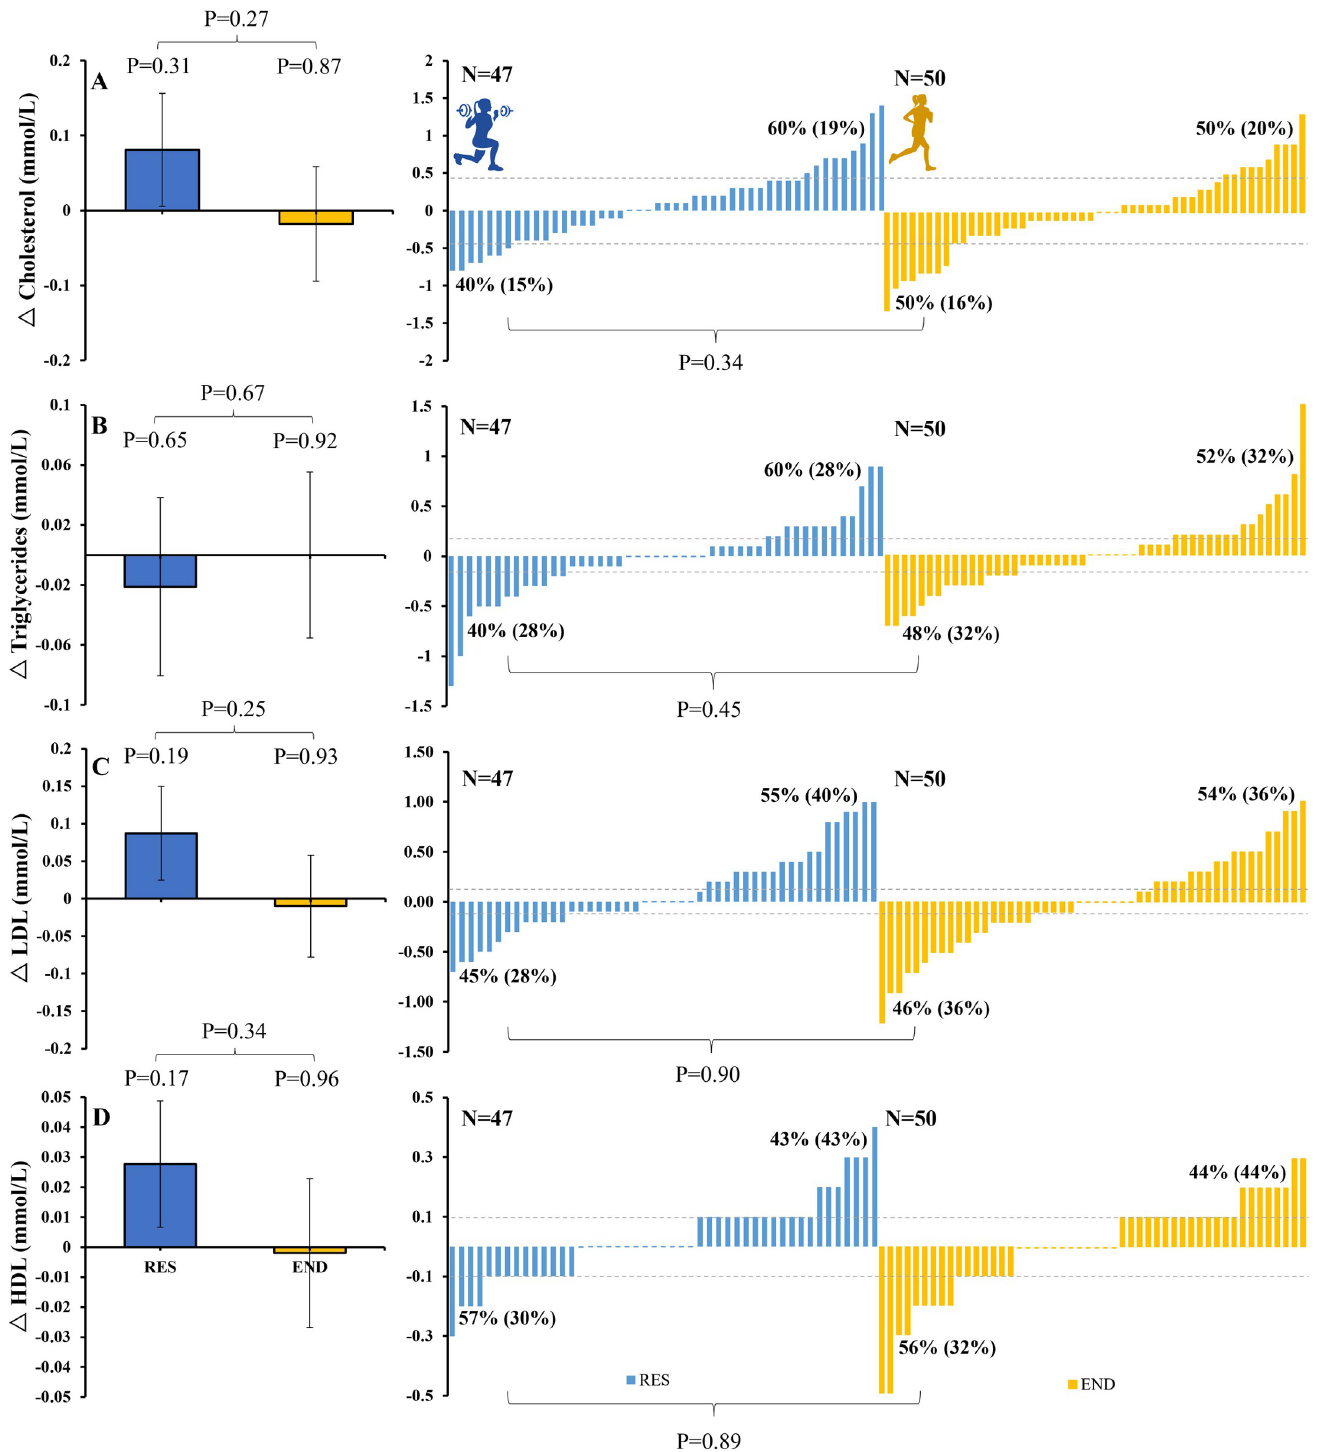
Fig 4. Changes ( Δ ) with RES (blue) and END (yellow) training for cholesterol (top panel, A), triglycerides (panel B), LDL (panel C), and HDL (panel D) for group (left) and individual responses to RES (middle) and END (right) training. Dotted lines represent previously reported clinically meaningful changes. A 10% decrease in cholesterol (equating to 0.439 mmol/L for our study participants) was associated with a 15% decrease in coronary heart disease mortality [29]. A 19% decrease in triglycerides (equating to 0.182 mmol/L for our study participants) was associated with a 26% decrease in total mortality [26]. A 4% decrease in LDL (equating to 0.102 mmol/L for our study participants) was associated with a 8–12% decrease in the risk of coronary heart disease [25]. A 0.100 mmol/L increase in HDL was